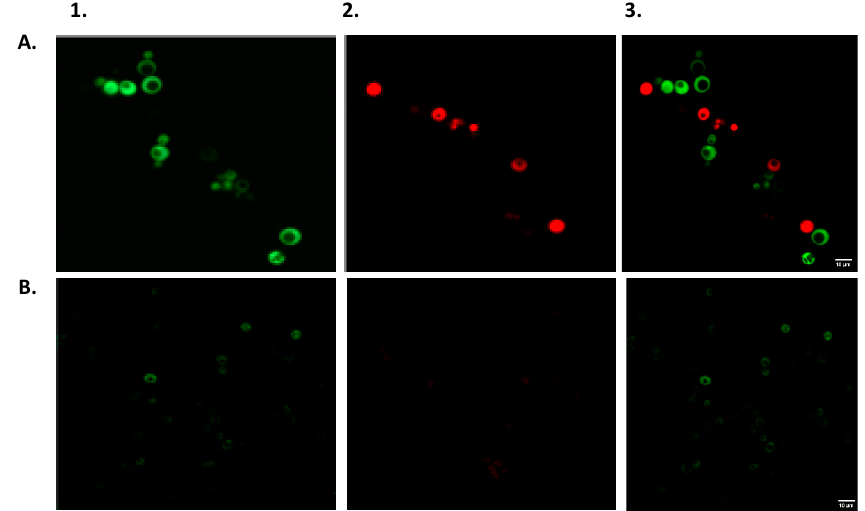
Figure 7. Simultaneous detection of estrogenic (E2) and androgenic (testosterone) model compounds by mixed ER-Ruby and AR-EGFP sensor strains in liquid culture. Images were obtained with a VF1200 confocal microscope (Olympus, Tokyo, Japan) with a 60 × 1.42 oil objective, following an 18 h incubation at 30 °C. Images were taken in a sequential mode using λ ex = 488 nm and λ em = 505–540 nm for the EGFP signal (column 1) and λ ex = 561 nm and λ em = 570 λ 620 nm for Ruby (column 2). Merged images are shown in column 3. Row ( A )—a testosterone/E2 mixture, 250 ng/l each; Row ( B )—no ligand.